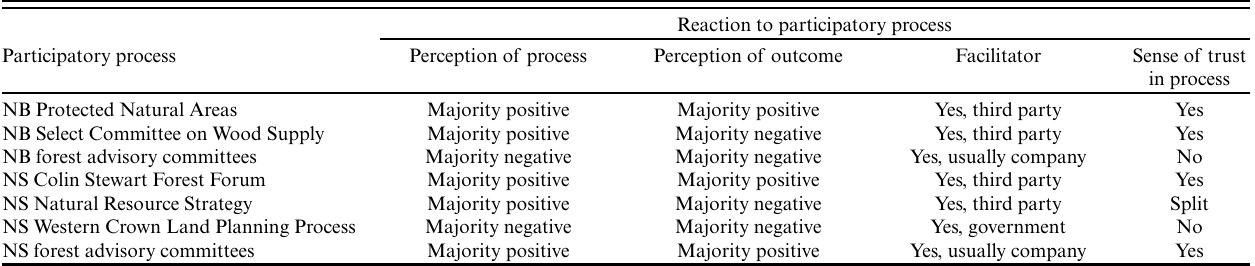
Table 4. Comparison of selected participatory processes in New Brunswick (NB) and Nova Scotia